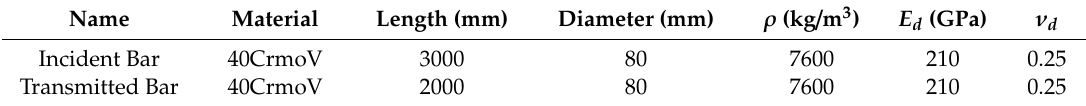
Table 2. Material parameters of the Split-Hopkinson pressure bar.